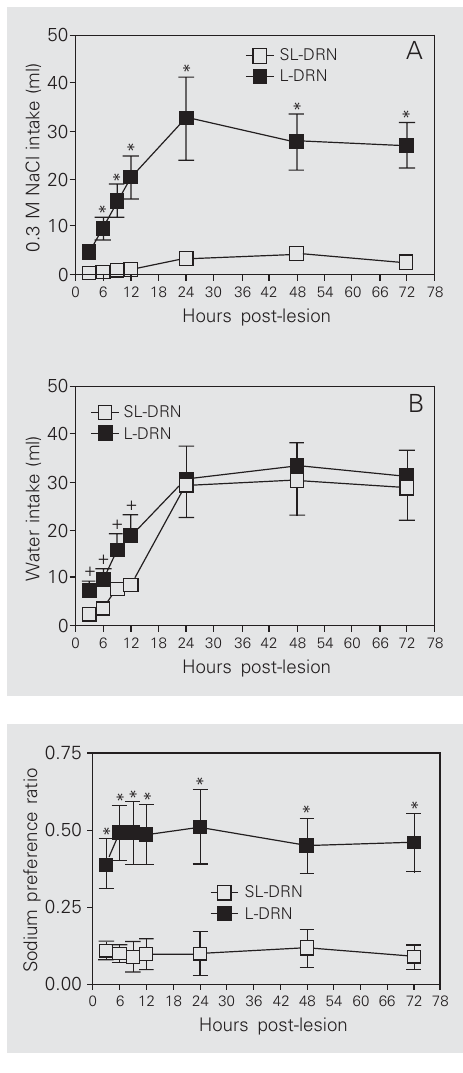
Figure 4. Sodium preference of dorsal raphe nucleus-lesioned (L-DRN, filled squares) and sham-lesioned rats (SL-DRN, open squares) under basal con- ditions. Data are reported as means ± SEM. *P < 0.02 com- pared to the SL-DRN group (two- way ANOVA followed by the Newman-Keuls